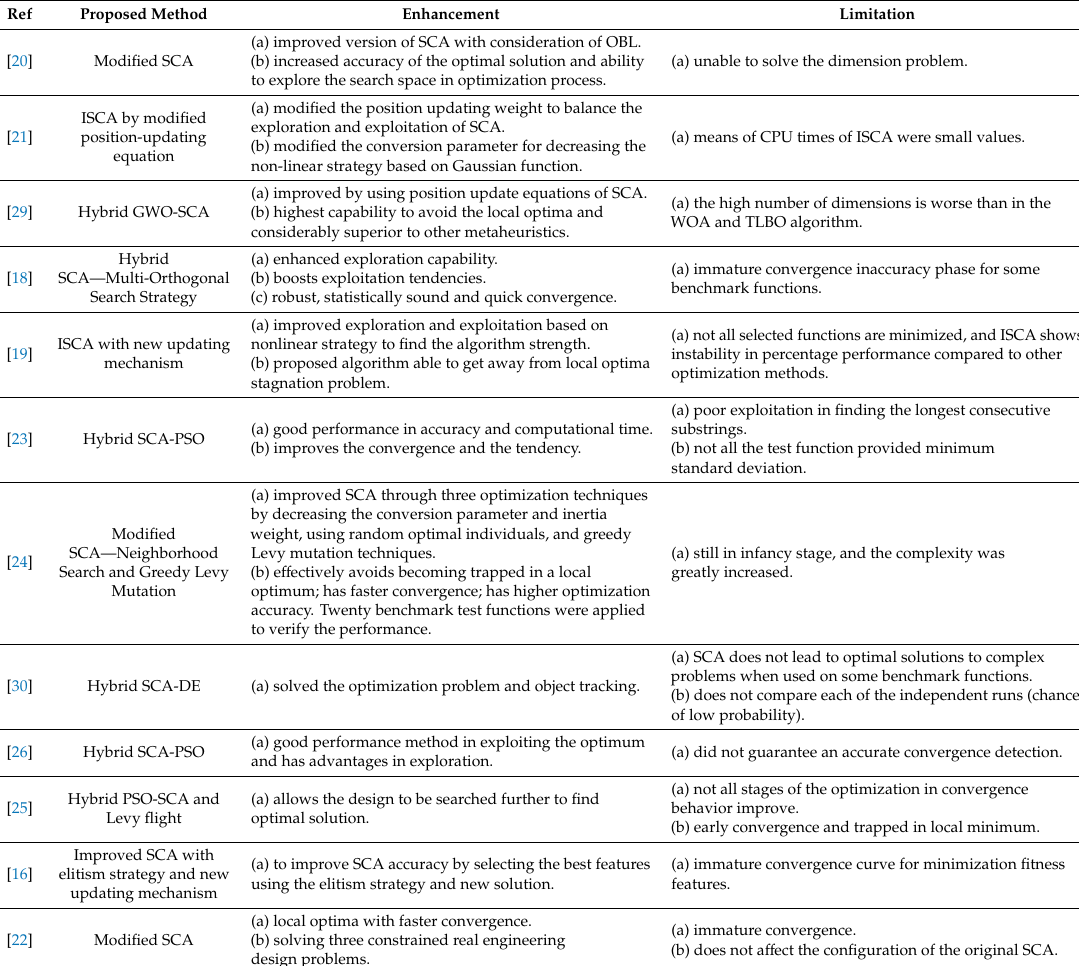
Table 1. Comparisons of state-of-the-art